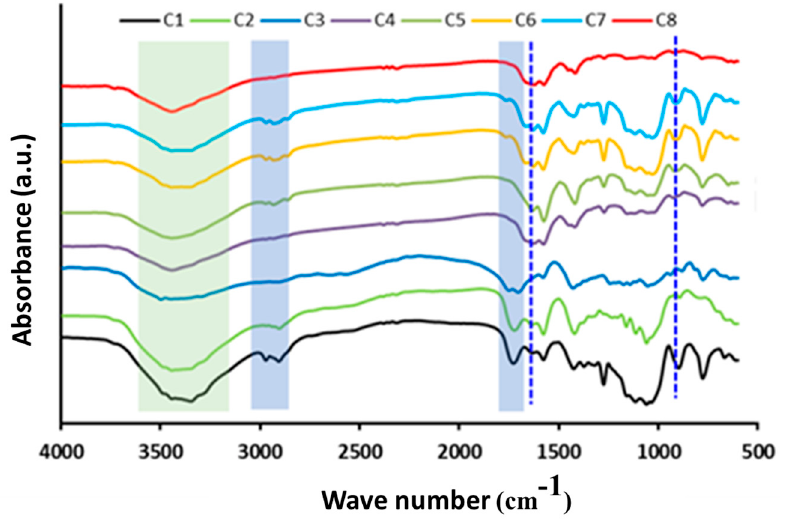
Figure 4. FTIR spectra of the unmodified CNC and modified CNC aerogels with different concentra- tions of TEPIC/CA/Urea. The dashed line indicates the change in peak trend and the appearance of new peaks.